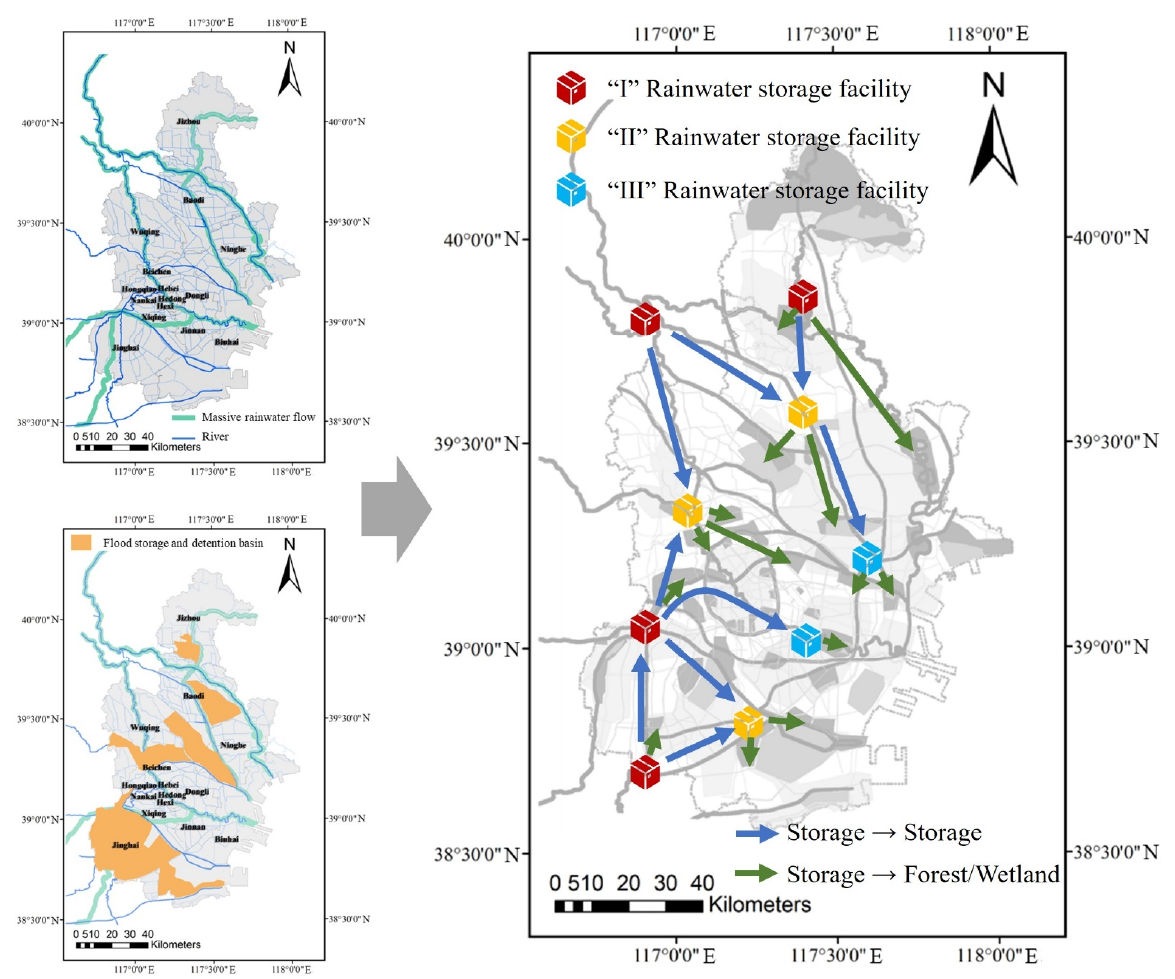
Figure 16. Rainwater storage facility spatial planning in Tianjin.